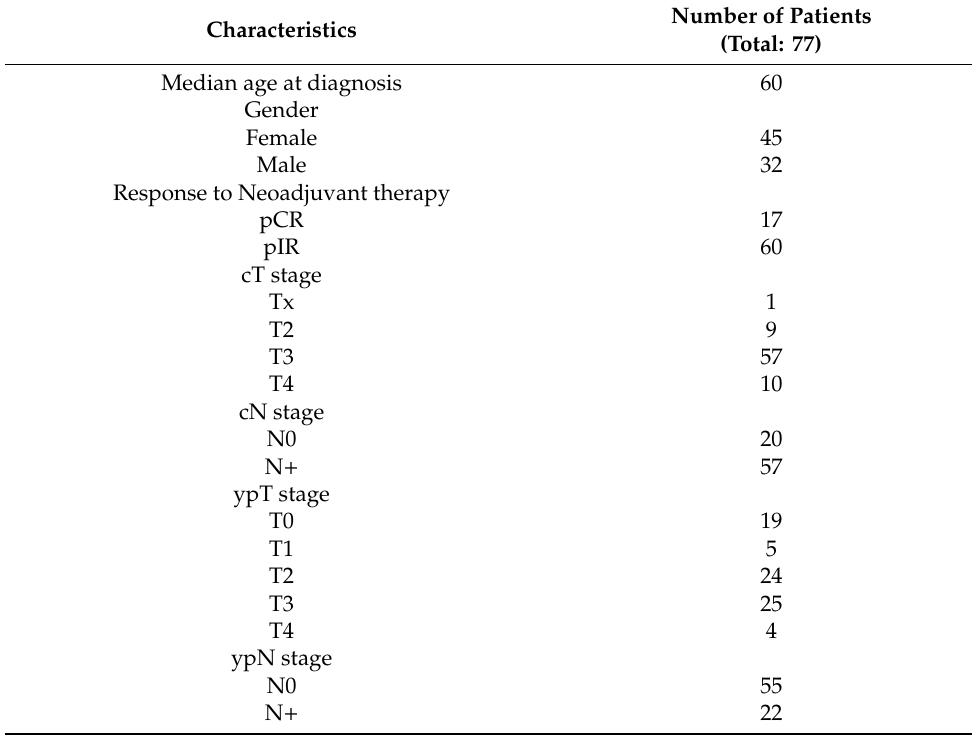
Table 1. Clinical and histopathological features of locally advanced rectal cancer patients included in this study.